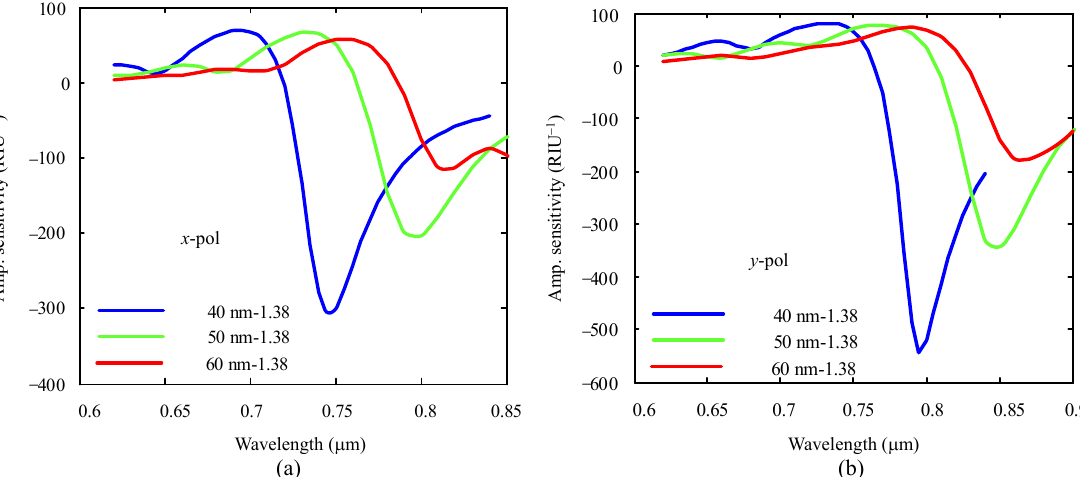
Fig. 8 Amplitude sensitivity as a function of wavelength with different gold layer thicknesses for: (a) x- and (b) y -polarized modes.